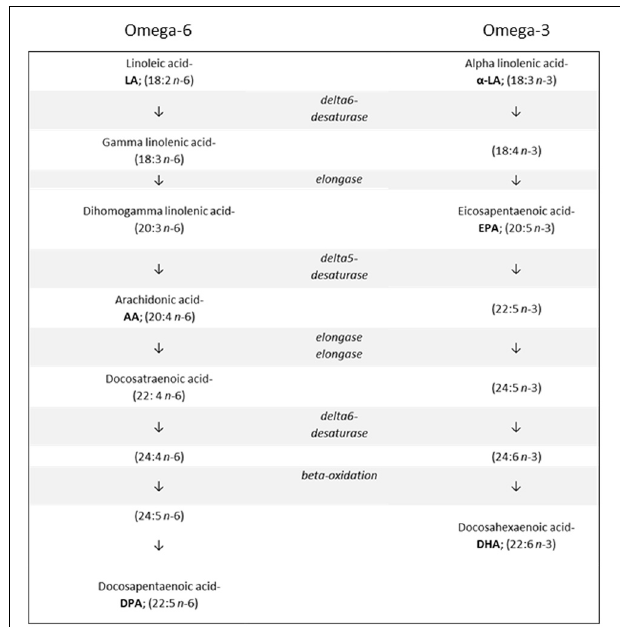
FIGURE 1 | The metabolic pathways involved in synthesizing n-6 and n-3 long chain polyunsaturated fatty acids from their respective shorter chain precursors.